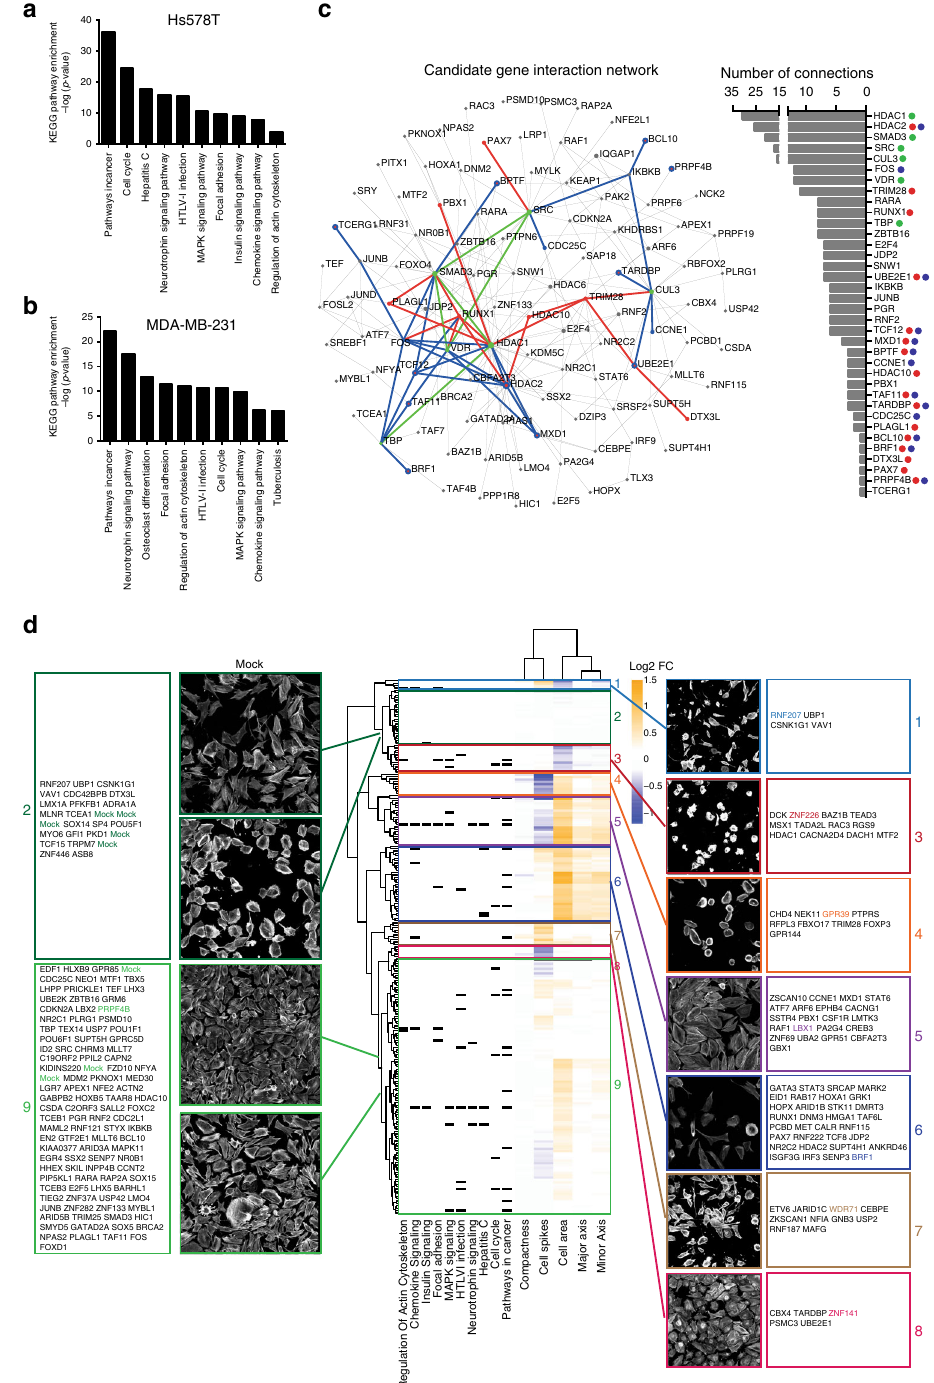
Fig. 4 Regulatory networks drive tumor cell migration. a Enrichment of KEGG pathways in PPI networks generated from Hs578T candidate genes and b MDA-MB-231 candidate genes. NetworkAnalyst was used to generate PPI networks. c Zero-order interaction network of combined Hs578T and MDA-MB-231 candidate genes reveals a highly connected sub-network of clinically associated genes (in blue). Candidate genes inhibiting cell migration in both cell lines are shown in red; central hubs are highlighted in green. The degree of connectivity (number of connections) is displayed on the right. d Phenotype-based clustering of the PKT validated candidate genes based on morphological changes in the Hs578T cell line. Per parameter, log2 fold change (FC) compared to mock control was calculated. Clustering was performed based on Euclidean distance and complete linkage